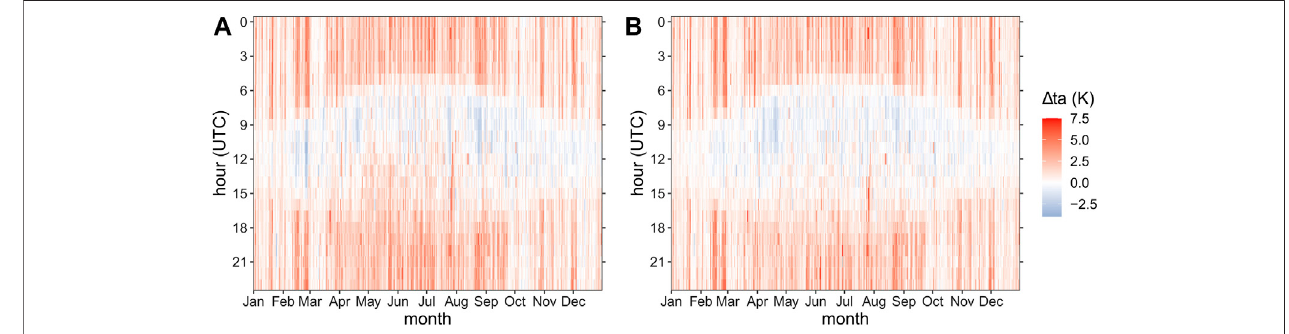
FIGURE 10 | Hourly air-temperature difference ( Δ ta ) for Amsterdam between (A) all CWS in LCZ 2 (compact midrise) and (B) all PWRS in LCZ 2, and PRWS at Schiphol airport, LCZ D (low plants) during 2019 ( Δ ta LCZ 2 – LCZ D ). CWS data are displayed at QC level o3 after application of CrowdQC+ in default settings (cf. Table 2 ). CWS and PRWS data for LCZ 2 were fi rst averaged across stations, then data at Schiphol airport subtracted.